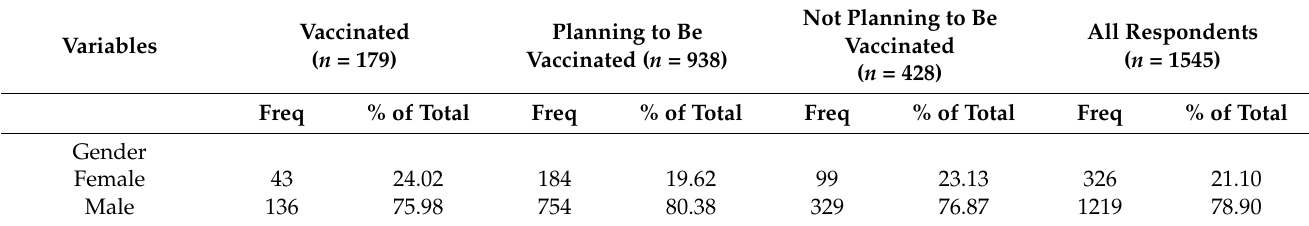
Figure 1. Distribution of the respondents based on their vaccination status. Table 1. Vaccination Status and Respondents’ Demographic